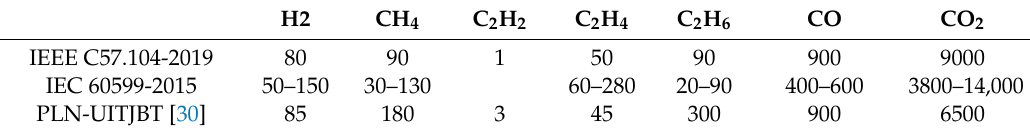
Table 4. Comparison of typical normal concentration values of dissolved gases